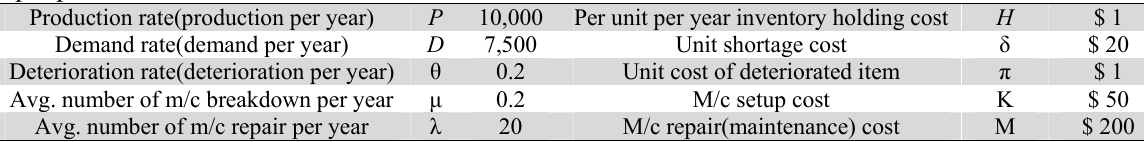
Input parameters